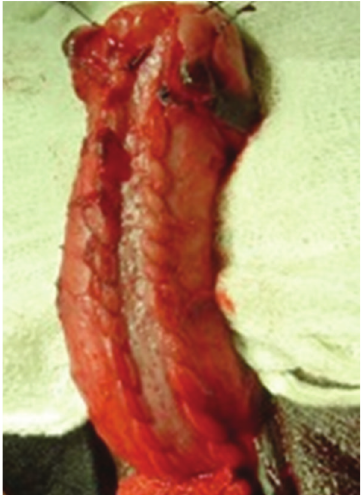
Figure 2: BMG placement in Asopa